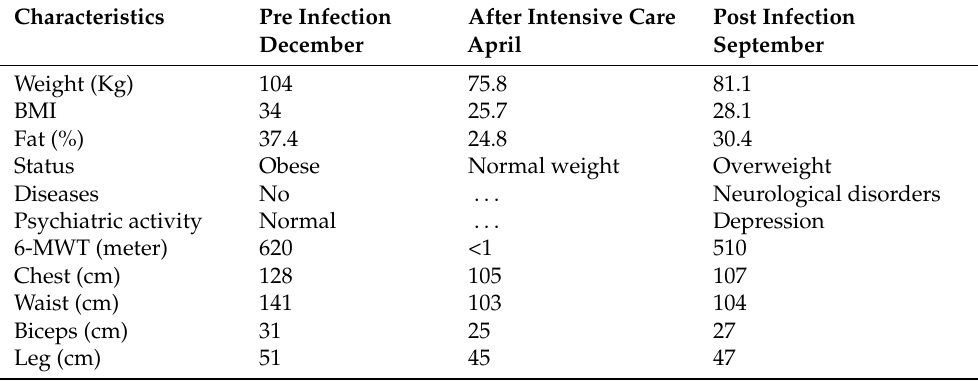
Table 1. Anthropometric measure from pre to post infection. Abbreviations: 6-Minute Walking Test (6-MWT); Body Mass Index